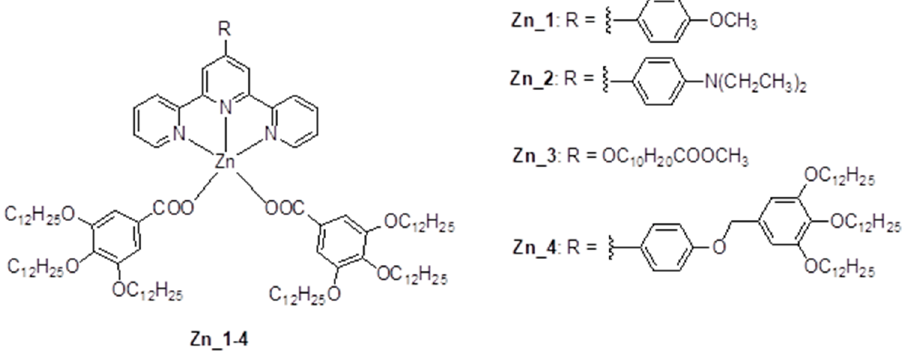
Figure 1. Chemical structure of the Zn(II) coordination complexes previously reported [27,28].